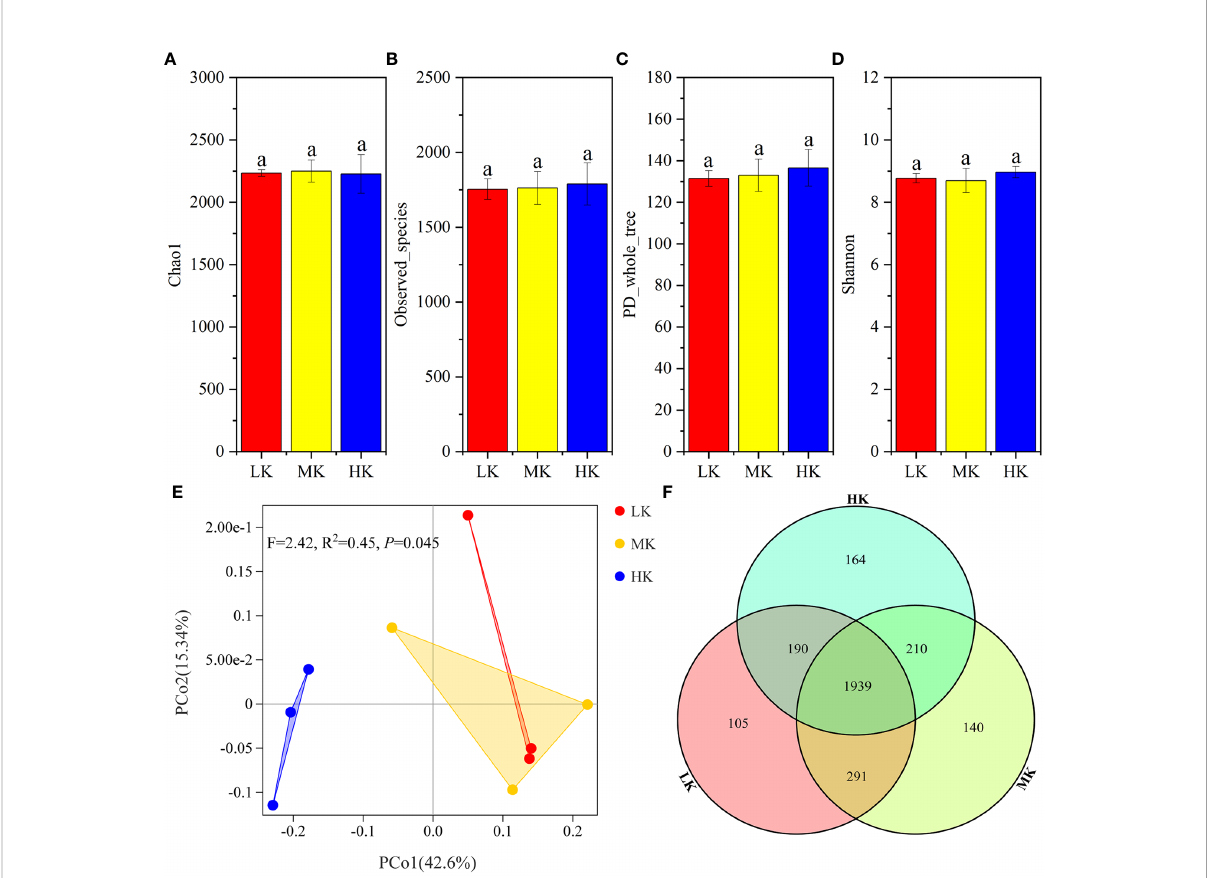
FIGURE 3 Similarity and differentiation of the bacterial community with different fertilization treatments. (A-D) . a -diversity of soils treated with different fertilization treatments; (E) . PCoA plot of bacterial communities at the OTU level; (F) . Venn diagram of exclusive and shared bacterial taxa at the OTU level. Values with the same lowercase letters are not signi fi cantly different among the different treatments (LSD test). LK, Low amount of K 2 SO 4 ; MK, Middle amount of K 2 SO 4 ; HK, High amount of K 2 SO 4